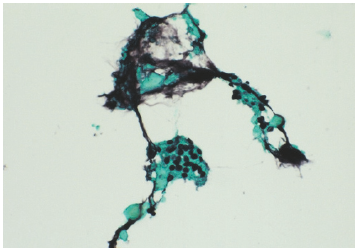
Figure 4: Grocott's methenamine silver staining of bronchoalveolar lavage fluid samples obtained on the day of admission revealed a small number of cystic forms of Pneumocystis